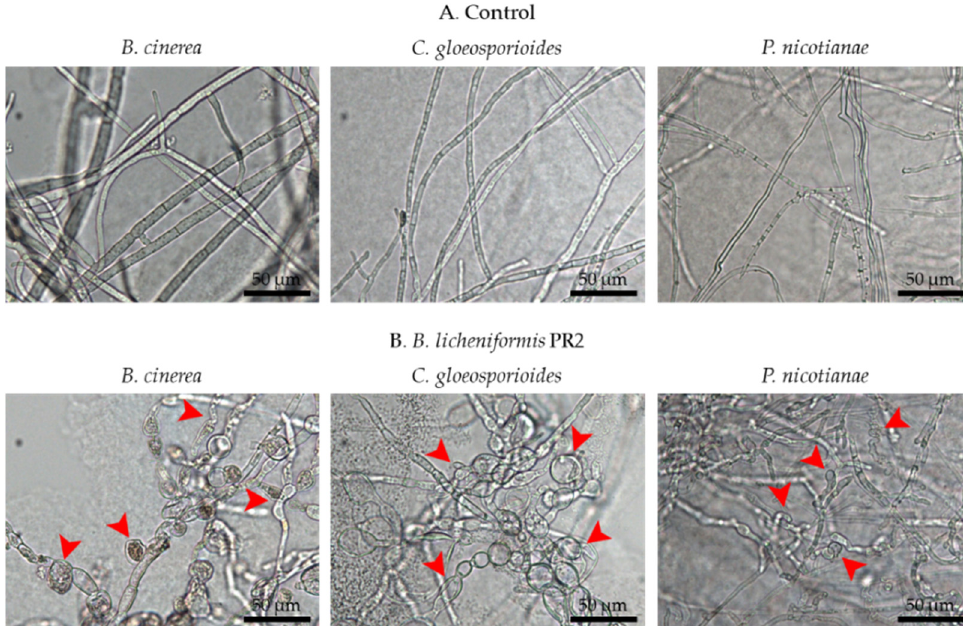
Figure 4. Light microscope images showing hyphal morphologies of B. cinerea, C. gloeosporioides , and P. nicotianae : ( A ) control and ( B ) treatment with B. licheniformis PR2. Arrows indicate abnormal structures caused by B. licheniformis PR2.